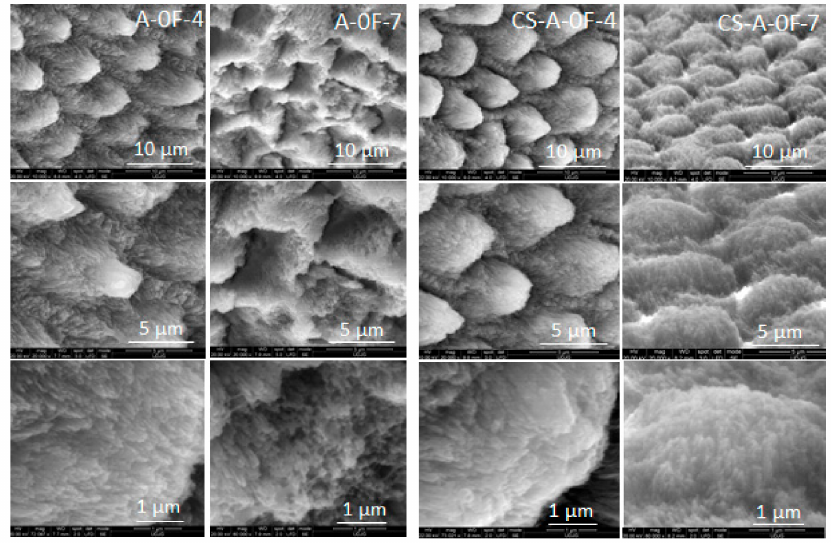
Figure 2. Top-view SEM images of the remineralized A-0F-(4/7) and CS-A-0F-(4/7) samples.